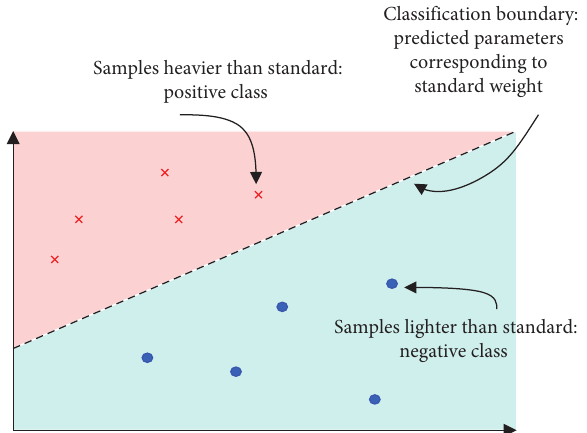
Figure 1: Schematic diagram of converting the parameter opti- mization problem to a classification